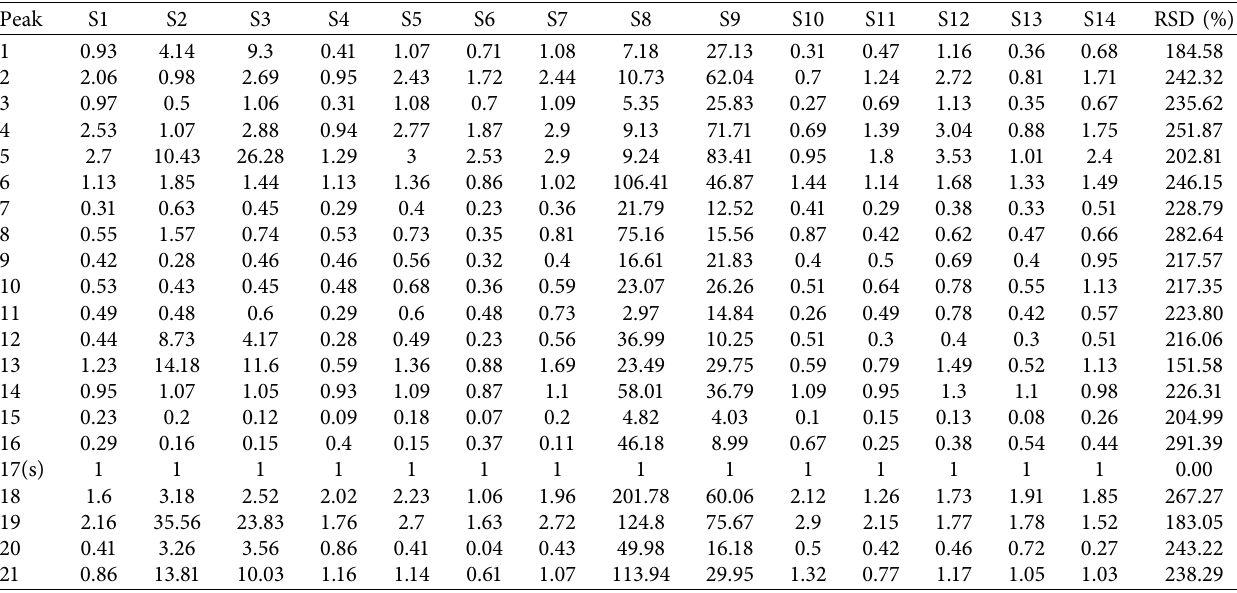
Table 5: Relative peak areas of common peaks in fourteen batches of samples.